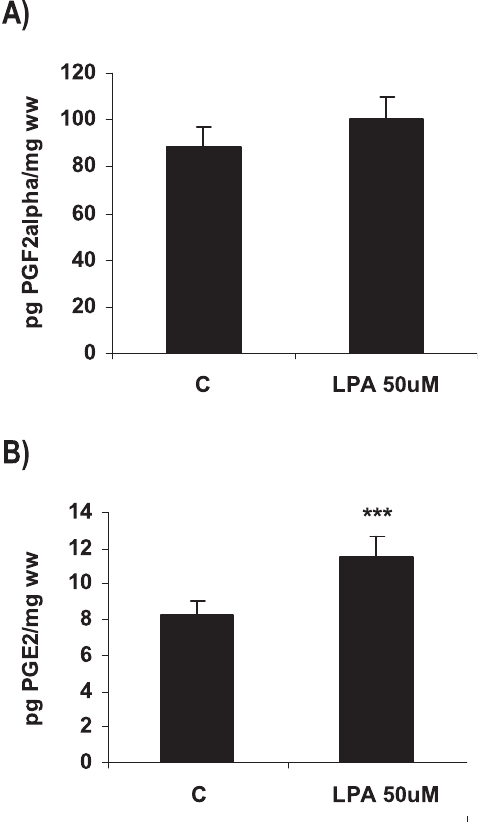
Figure 4. Effect of LPA on the production of prostagandins in the rat uterus during the window of implantation. Uterine strips from rats pregnant on day 5 of gestation (implantation window) were incubated with LPA 50 m M for 6 h and the production of PGF2 a (A) and PGE2 (B) was determined by radioimmunoassay. In B: *** p , 0.001 vs C. Results are shown as means 6 sem. N=4–6 for each point. C: